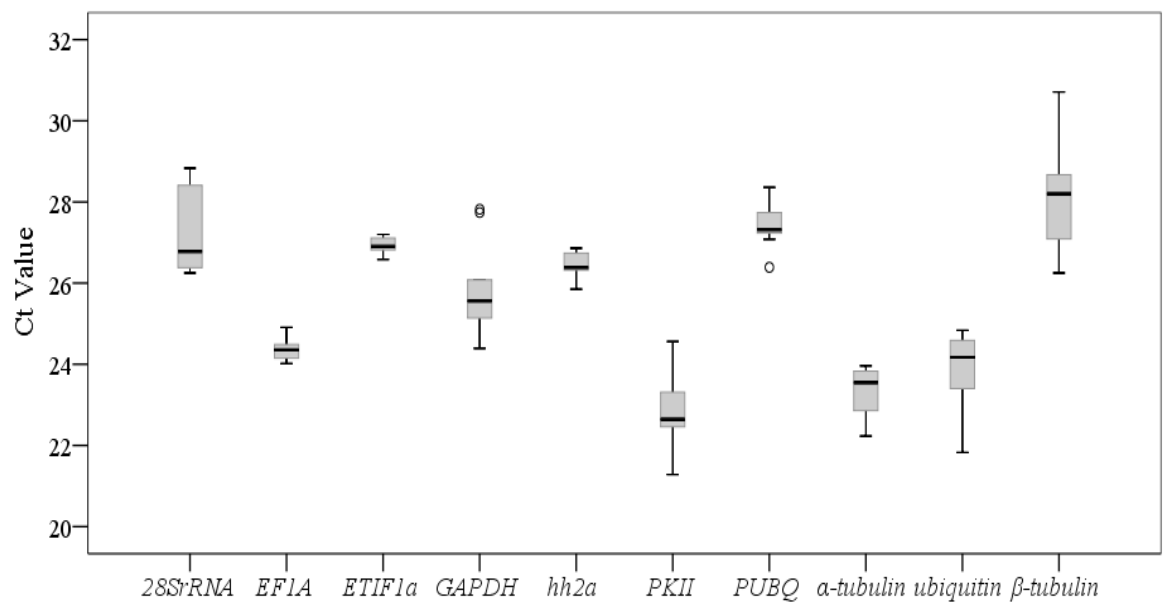
Figure 1. Expression levels of 10 candidate reference genes in different samples. Lines across the boxes depict the medians. Boxes indicate the interquartile range. Whiskers represent 95% confidence intervals and black circles represent the deviated values.